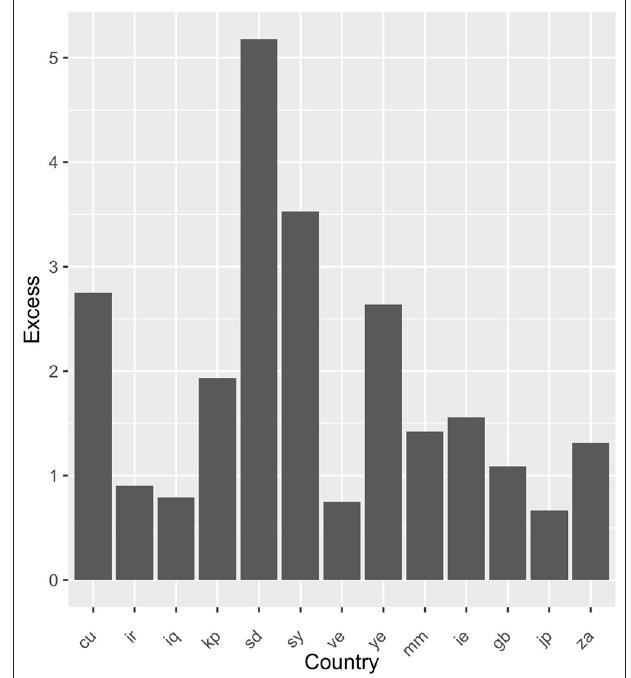
FIGURE 5 | Ratio of number of URLs that did not return HTML in a country to the number of URLs that did not return HTML for